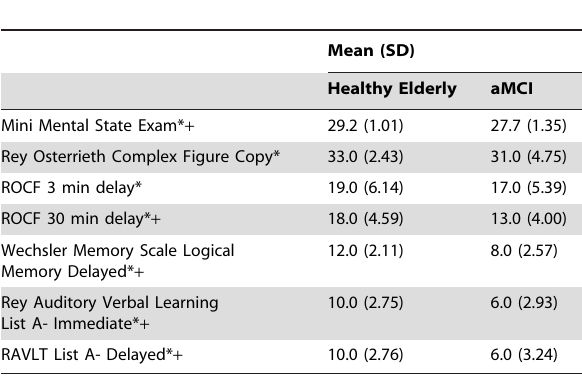
Table 2. Neuropsychological tests used to classify Healthy Elderly and aMCI